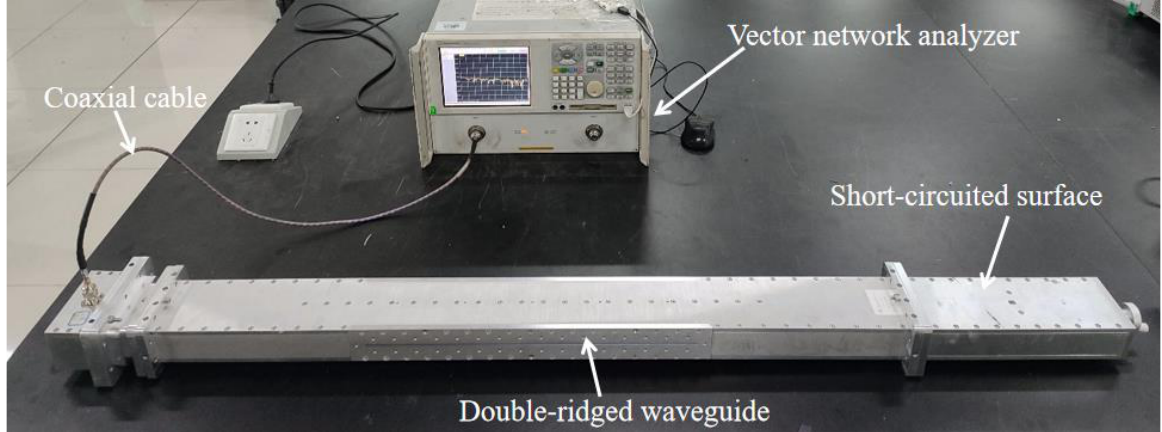
Figure 7. The photograph of adjusting short-circuited surface by a vector network analyzer.